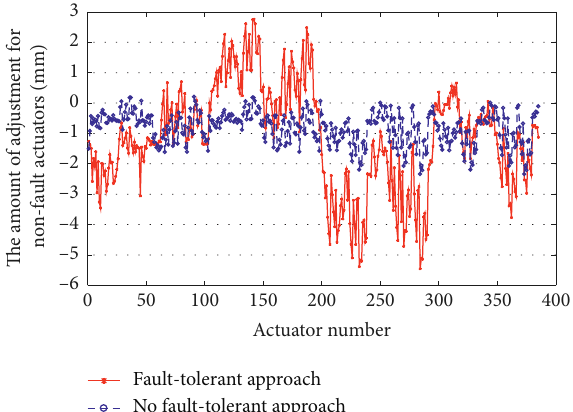
Figure 7: Nonfault actuators’ stroke at 20deg